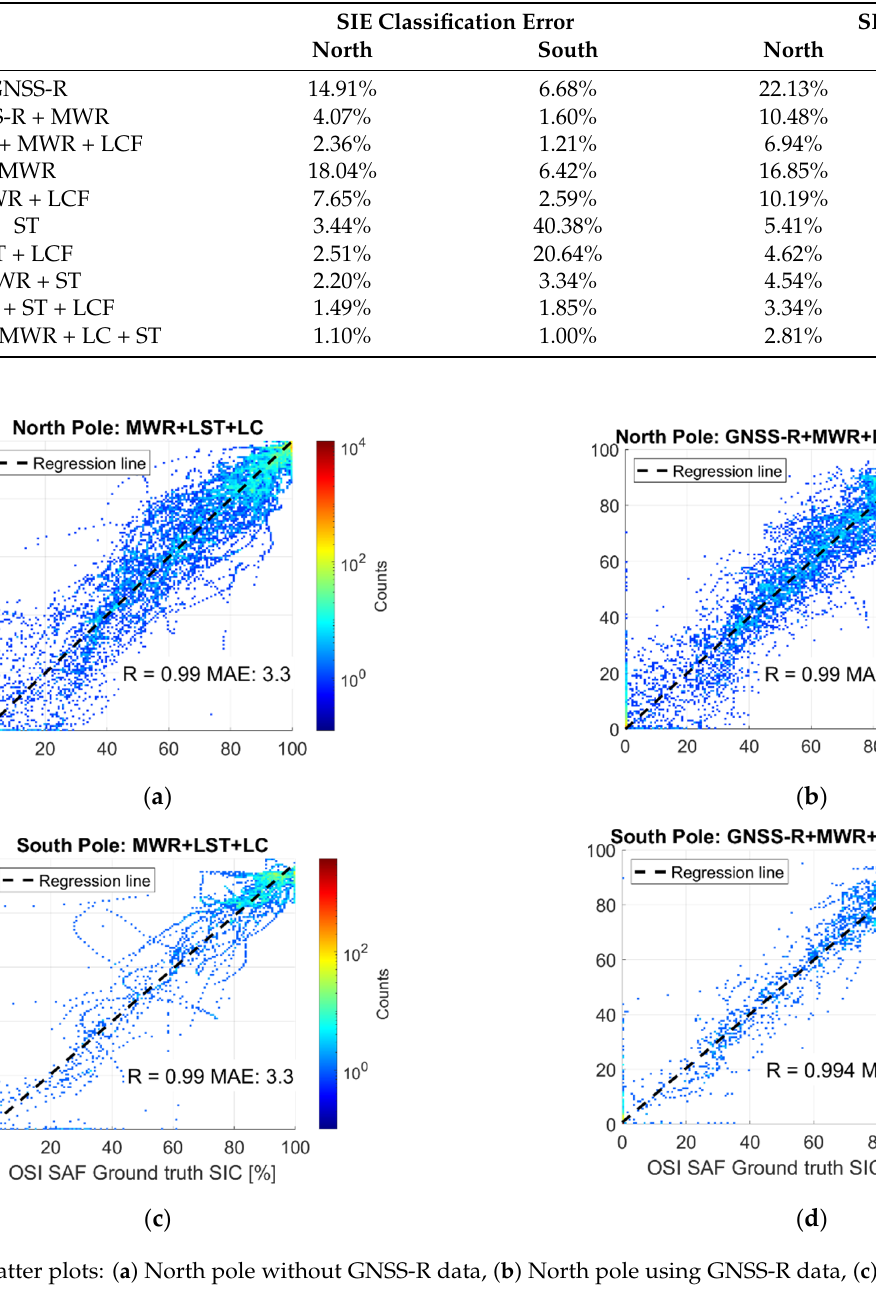
Figure 6. Scatter plots: ( a ) North pole without GNSS-R data, ( b ) North pole using GNSS-R data, ( c ) South pole without GNSS-R data ( d ) South pole using GNSS-R data.